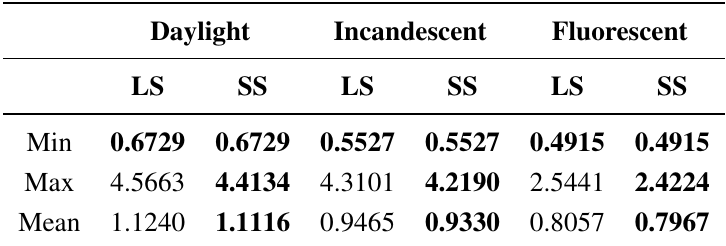
Table 5. ∆ E error for three different illuminants on the Simon Fraser dataset 00 (Least-Squares (LS), Spherical Sampling